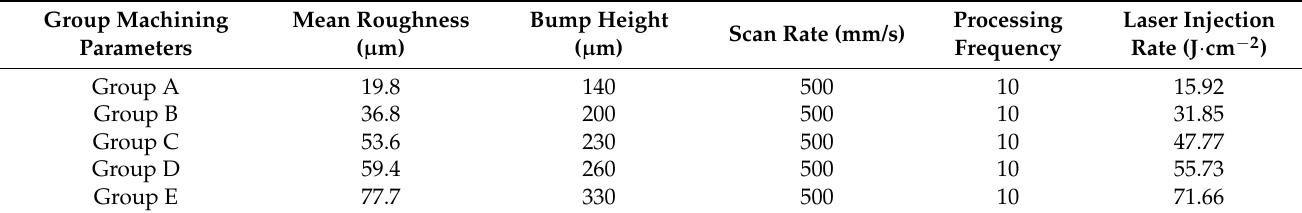
Figure 5. ( a ) The influence of templates processed with different laser fluxes on the sensitivity of the transferred CCP/LIG sensor; ( b ) Relationship between the LIG content and CCP/LIG resistivity; ( c ) The influence of LIG content in CCP/LIG on sensor sensitivity. Table 1. The relationship between sensor properties and machining parameters.